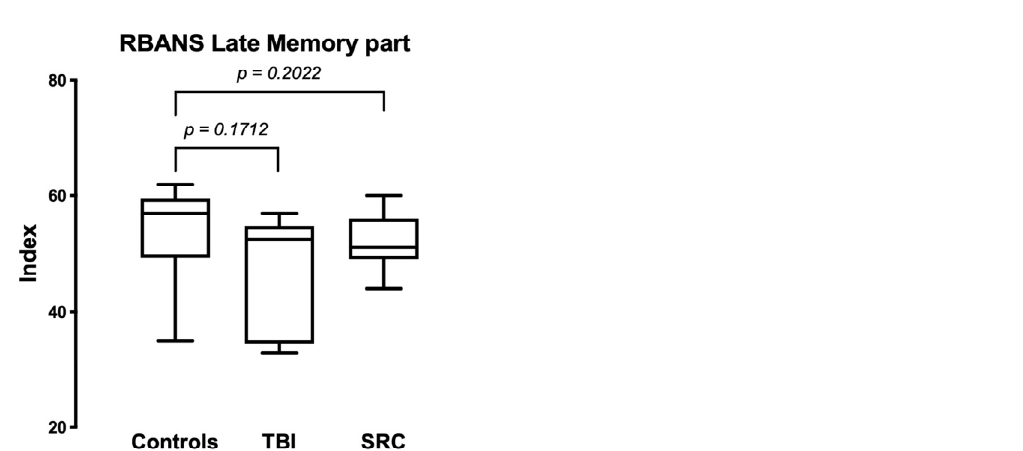
Figure 2. Each domain of RBANS is shown for TBI, rSRC, and HC. Significant differences in RBANS Memory score were detected between HC and TBI patients, as well as rSRC athletes. For the other domains of the RBANS, there were no significant differences among the groups. TBI: traumatic brain injuries; rSRC: repeated sport-related concussions; HC: healthy controls; RBANS: repeatable battery for the assessment of neuropsychological status. * Statistical significance with p value < 0.05.